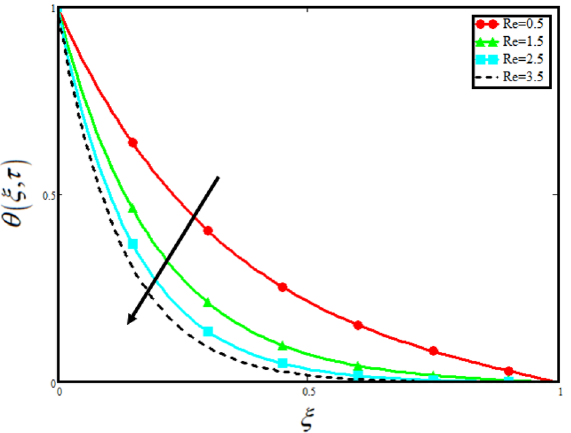
Figure 6. Variation in temperature against different values of Re when τ = 1 , φ hnf = 0.02 , Pr = 21 and α = 0.5 .